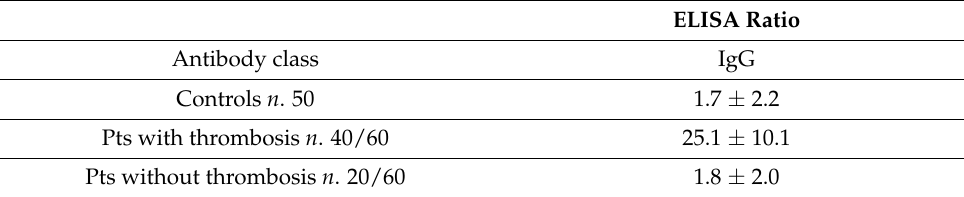
Table 4. Anti-endothelial cell antibodies (AECAs) in the 60 PV patients and controls.